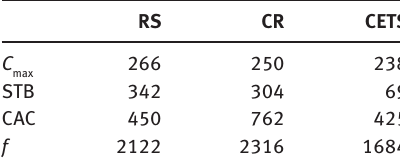
Table 3: Performance of